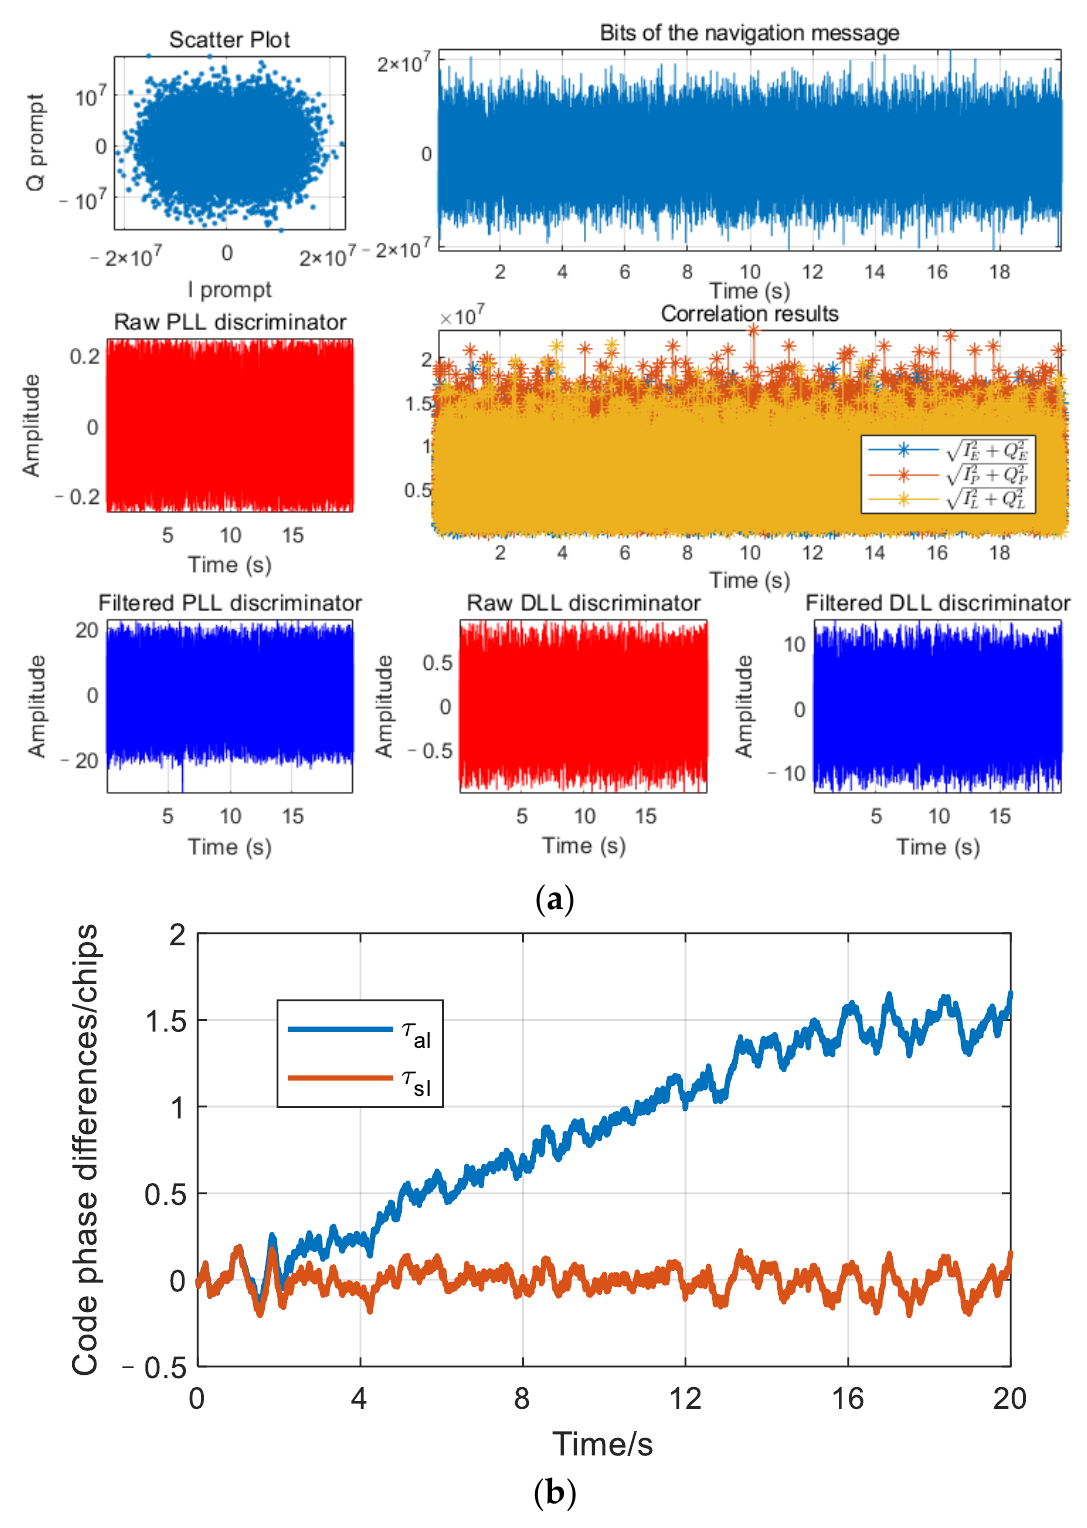
= 30 dBHz, D = 1 ). ( a ) Obtained results of soft- Figure 19. Results of the proposed strategy ( C/N Figure 19. Results of the proposed strategy (C/N 0 = 30 dBHz, D = 1). ( a ) Obtained results of 0 software receiver; ( b ) Code phase ware receiver; ( b ) Code phase difference.